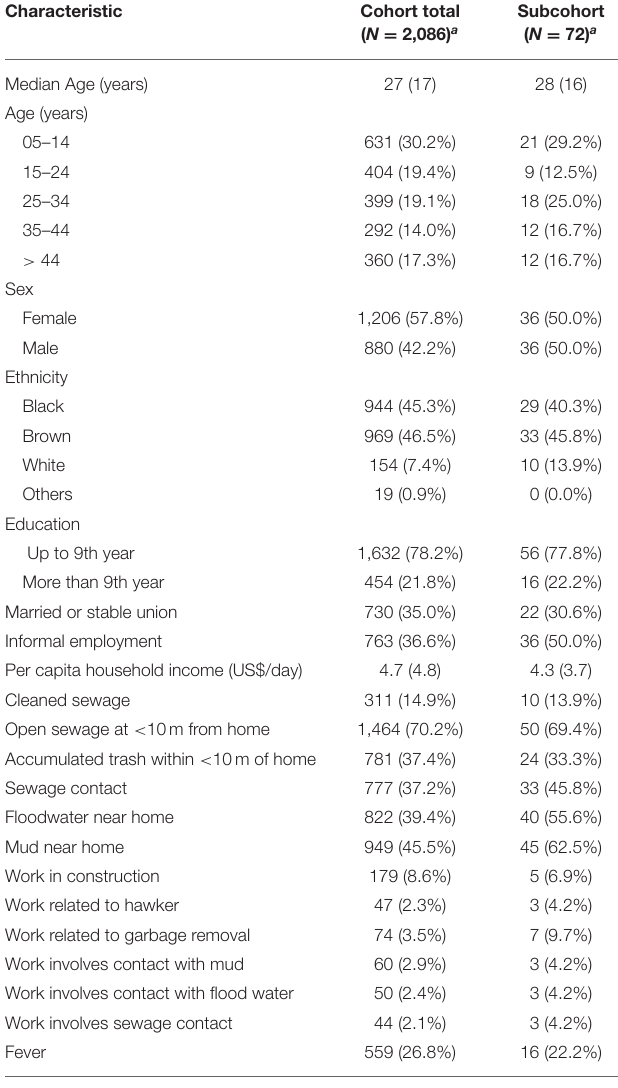
TABLE 1 | Sociodemographic and exposure characteristics of the participants enrolled in the study.